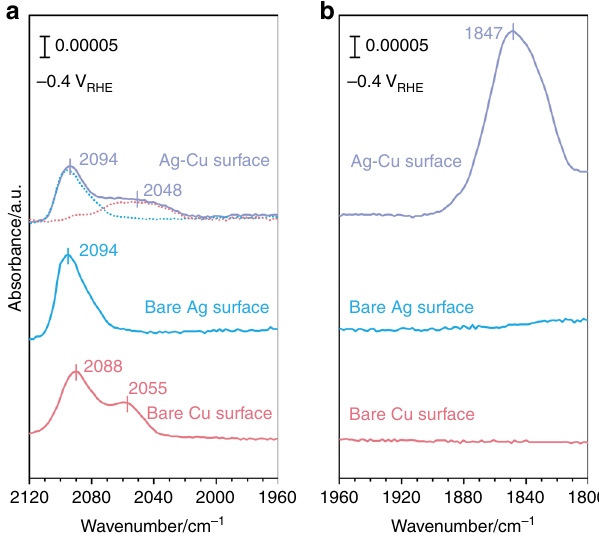
Fig. 5 Studies of surface-adsorbed CO on Cu, bare Ag and Ag-Cu fi lms. Operando attenuated total re fl ectance surface enhanced infrared absorption spectroscopy (ATR-SEIRAS) of surface adsorption. a The atop- bonded CO band on different surfaces under − 0.4 V RHE . b The bridge- bonded CO band on Ag-Cu fi lm under − 0.4 V RHE. The background is collected at 0.1 V RHE under Ar purge